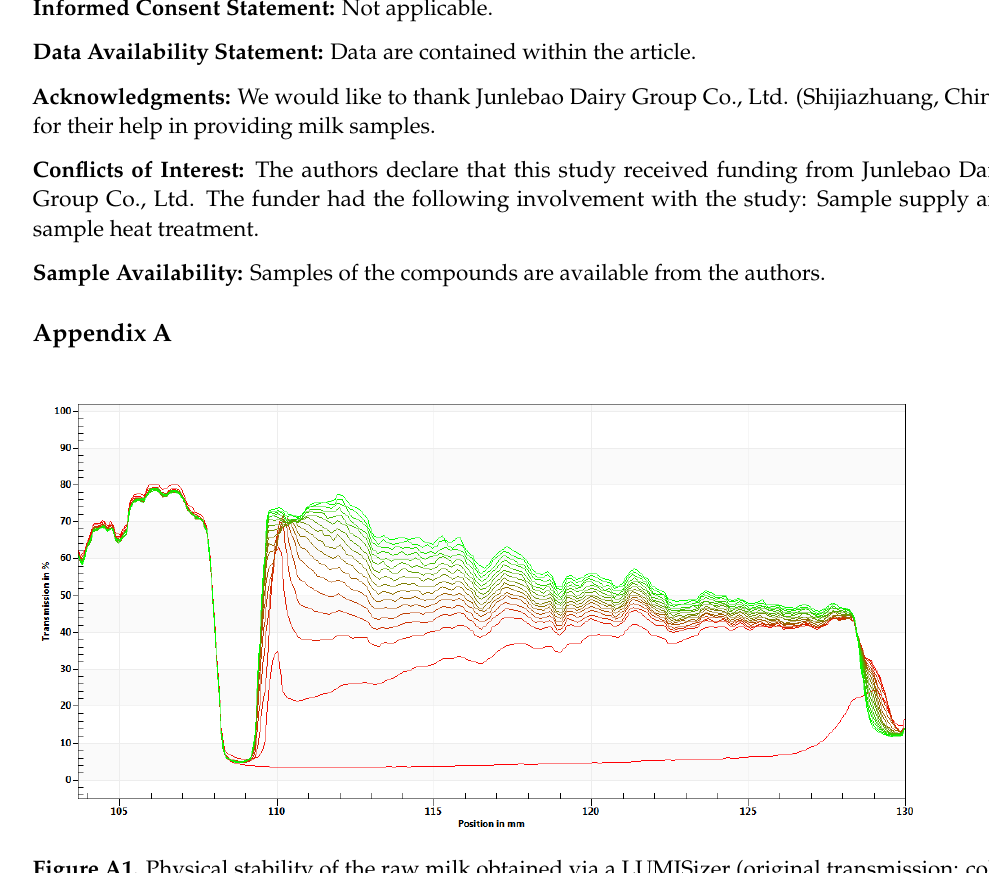
Figure A1. Physical stability of the raw milk obtained via a LUMISizer (original transmission: color lines change from red to green as time increases).